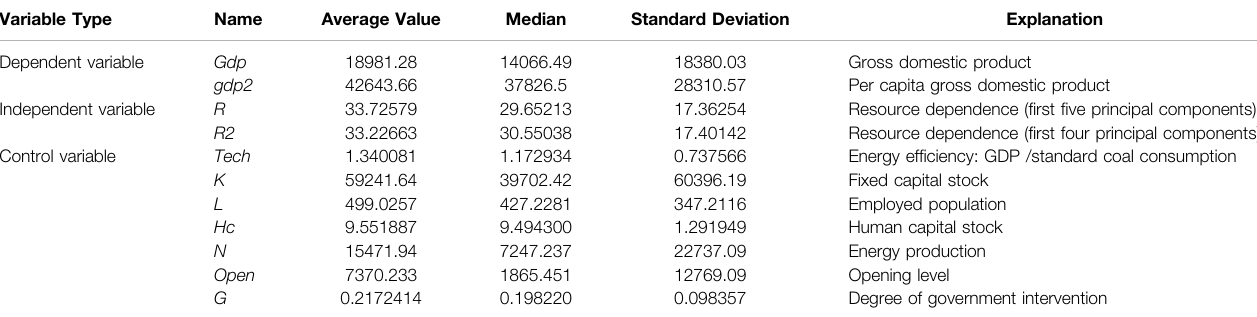
TABLE 2 | Explanation of variables.